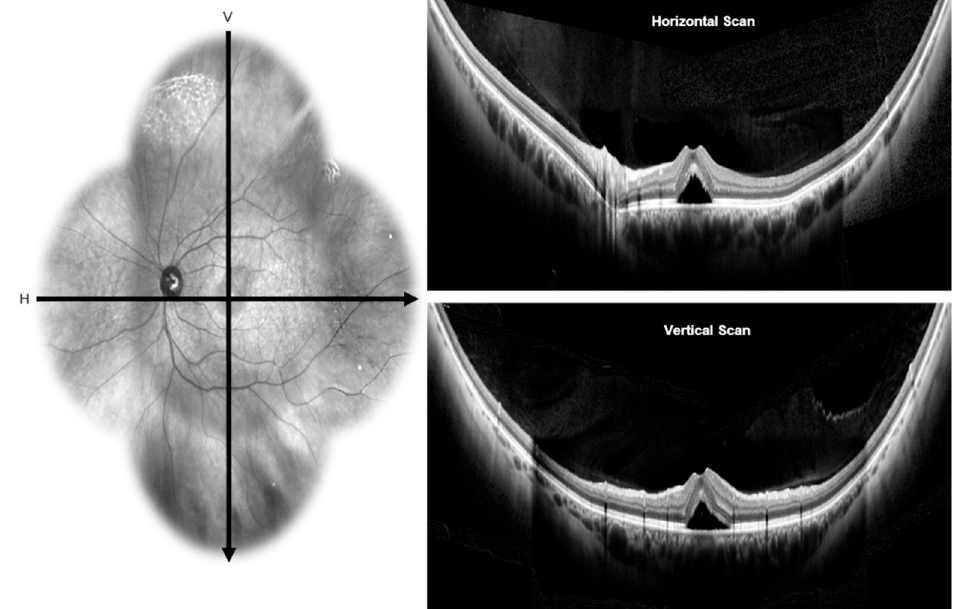
Figure 3. Wide-field optical coherence tomography: the infra-red image on the left side showing the horizontal and vertical scans passing through the fovea of an eye with CSCR. Wide-field optical coherence tomography scans on the right side shows presence of neurosensory detachment in horizontal (top) and vertical (bottom) scans.